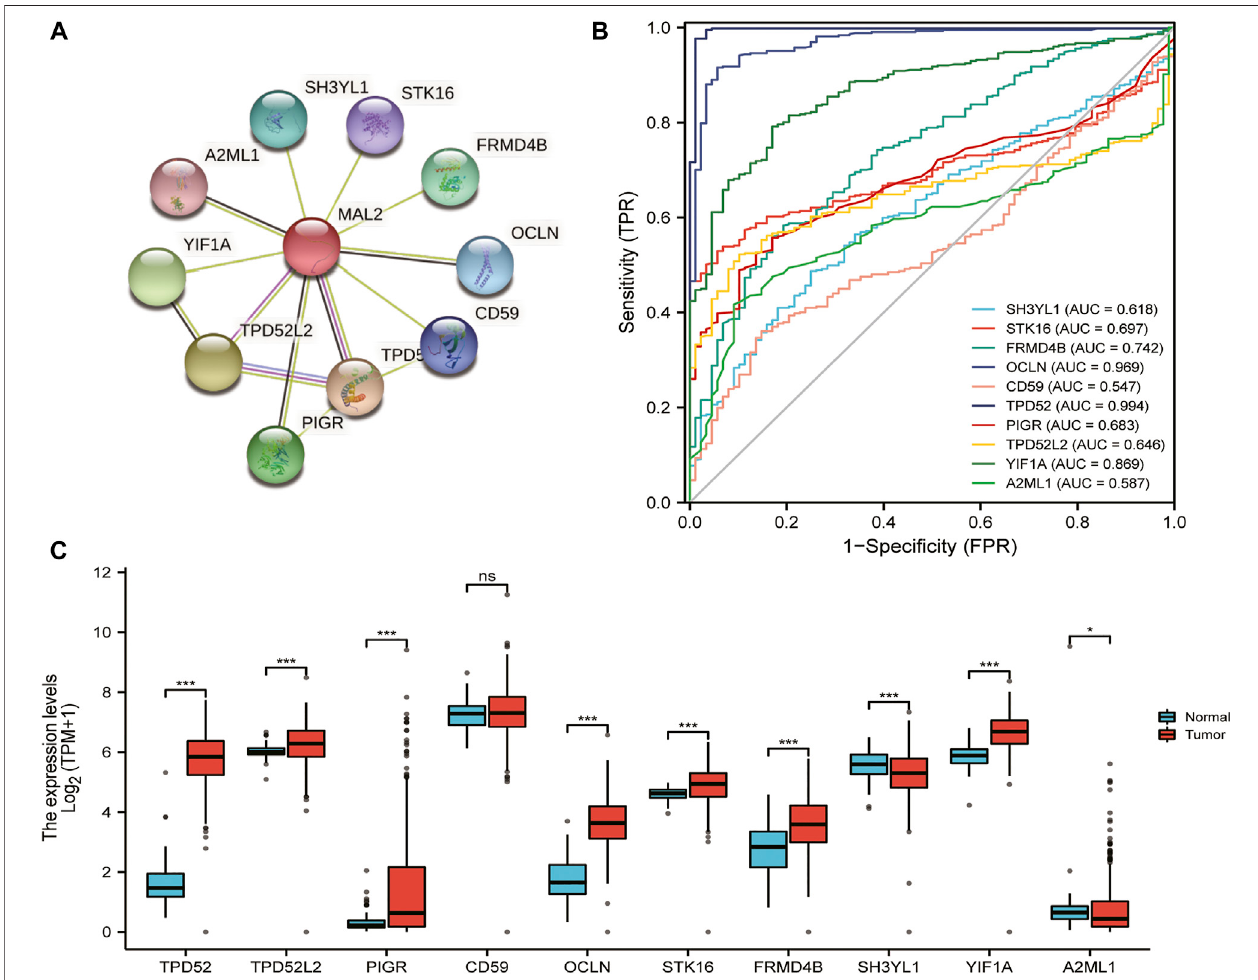
FIGURE 4 | Functional enrichment and protein – protein interaction (PPI) network of MAL2 in patients with OC. (A) PPI network by STRING database. (B) Areas under the curve (AUCs): 10 hub genes ’ AUCs in predicting prognosis of OC patients. (C) The expression analysis of 10 hub genes in OC.